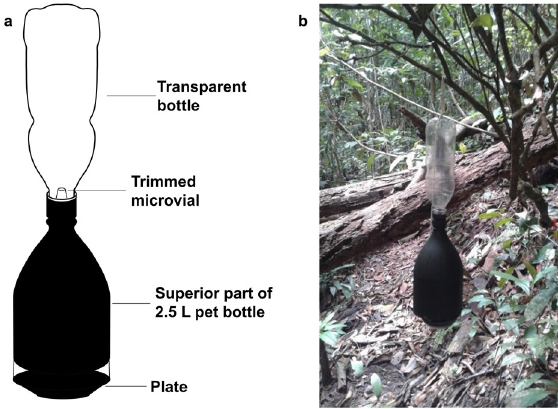
Figure 1. (a) Oviposition trap for the capture of coprophagous moth flies. (b) Trap placed in the